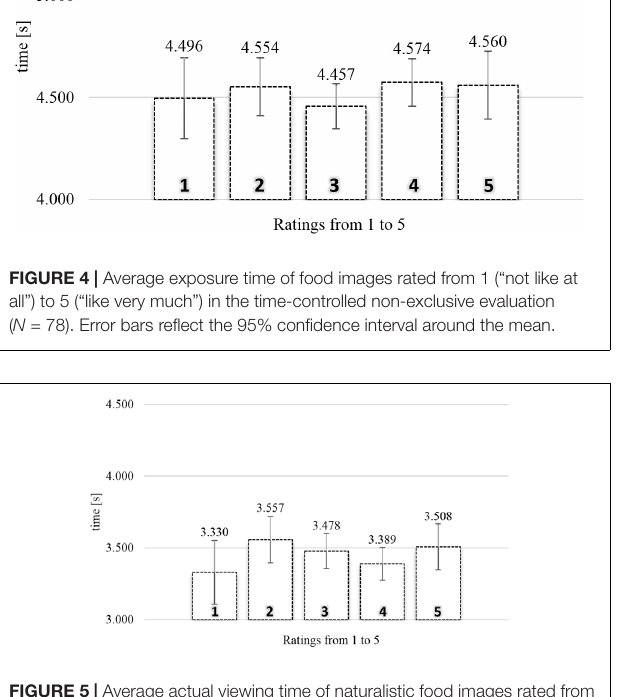
FIGURE 5 | Average actual viewing time of naturalistic food images rated from 1 (“not like at all”) to 5 (“like very much”) in the time-controlled non-exclusive evaluation ( N = 44). Error bars reflect the 95% confidence interval around the mean.